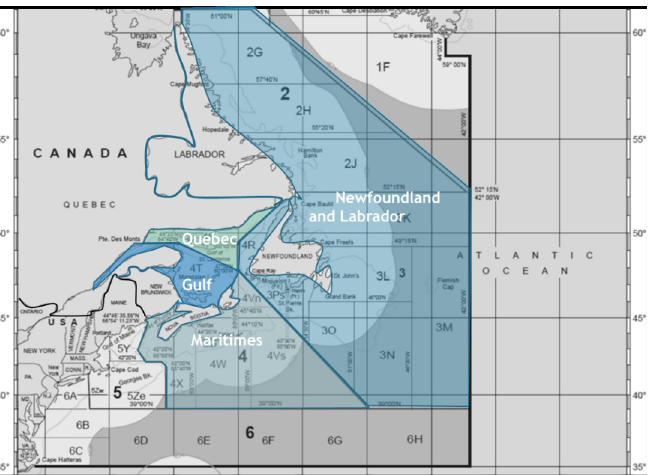
Fig 2. Eastern Canada as it relates to the Northwest Atlantic Fisheries Organization (NAFO) fishing areas with DFO management areas overlaid. For clarity approximate provincial borders have been emphasised in dark blue, U. S. and Canada border has been emphasised in black. In this assessment Gulf and Quebec management areas were treated as a single unit (figure modified from